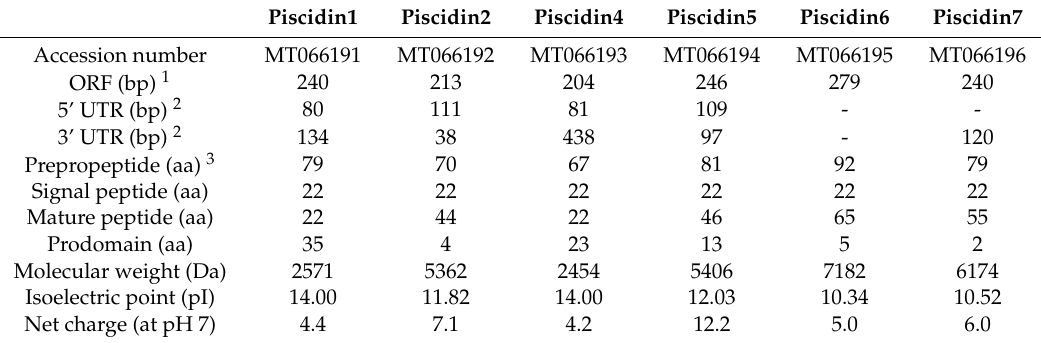
Table 1. Characterization of sea bass piscidin genes and peptides.